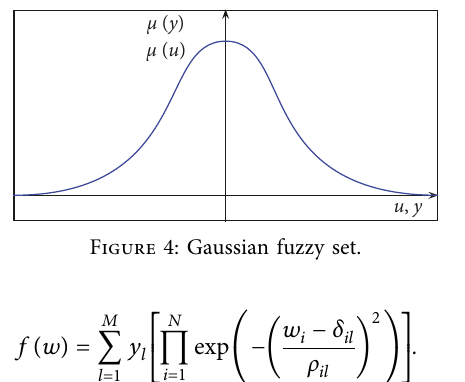
Figure 4: Gaussian fuzzy